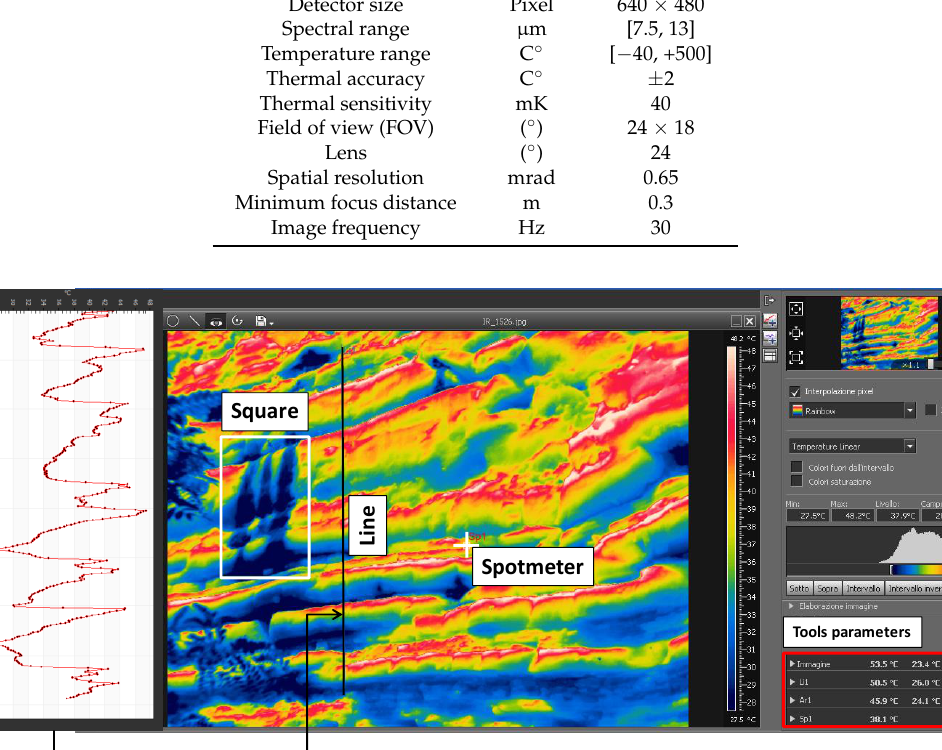
Figure 4. FLIR ResearchIR 3.4 sp3 software interface (FLIR,